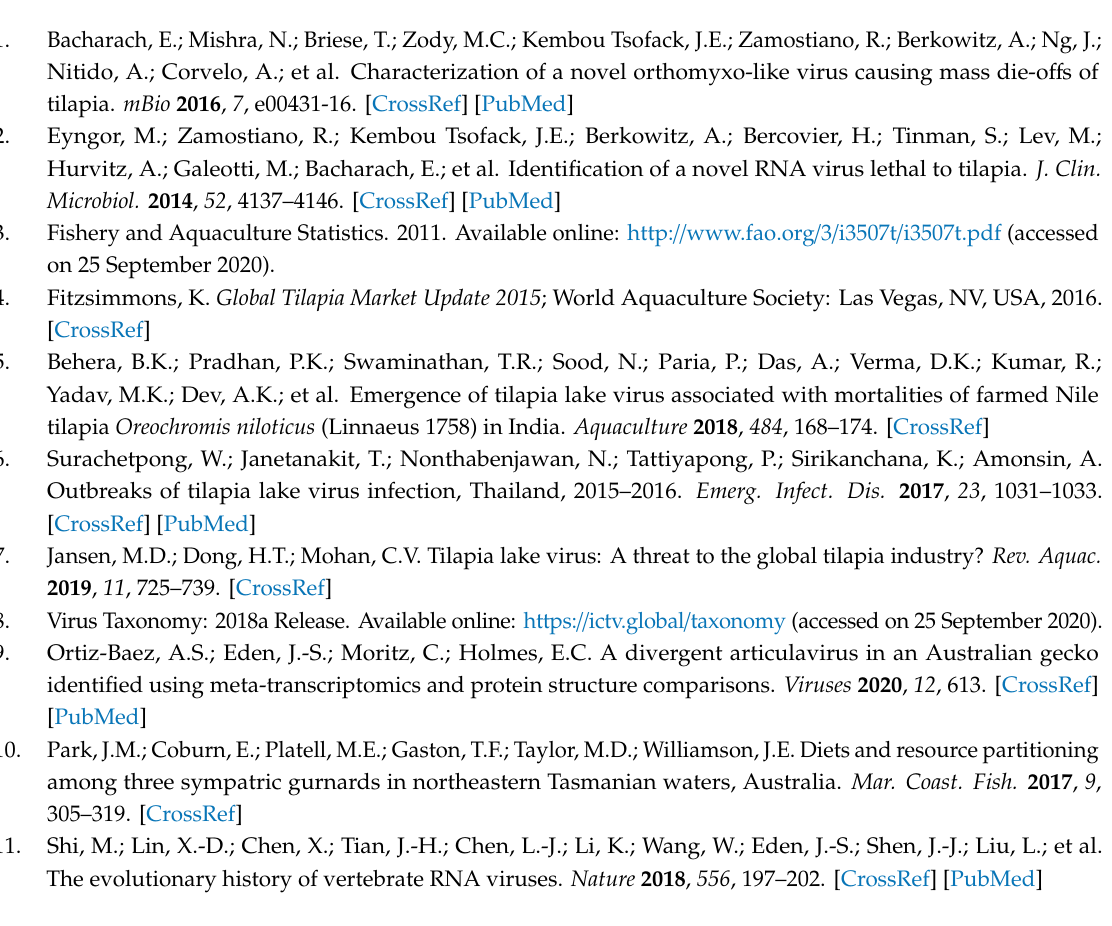
Table S1: List of primer sets used for the RT-PCR confirmation of Flavolineata virus in specimens of Meuschenia flavolineata ; Table S2: All virus transcripts identified in this study that fell across genomic segments within the Amnoonviridae ; Figure S1: Agarose gels electrophoresis showing PCR products from three sets of primers that target a region in the PB1 gene segment (RdRp) for ten individuals of Meuschenia flavolineata